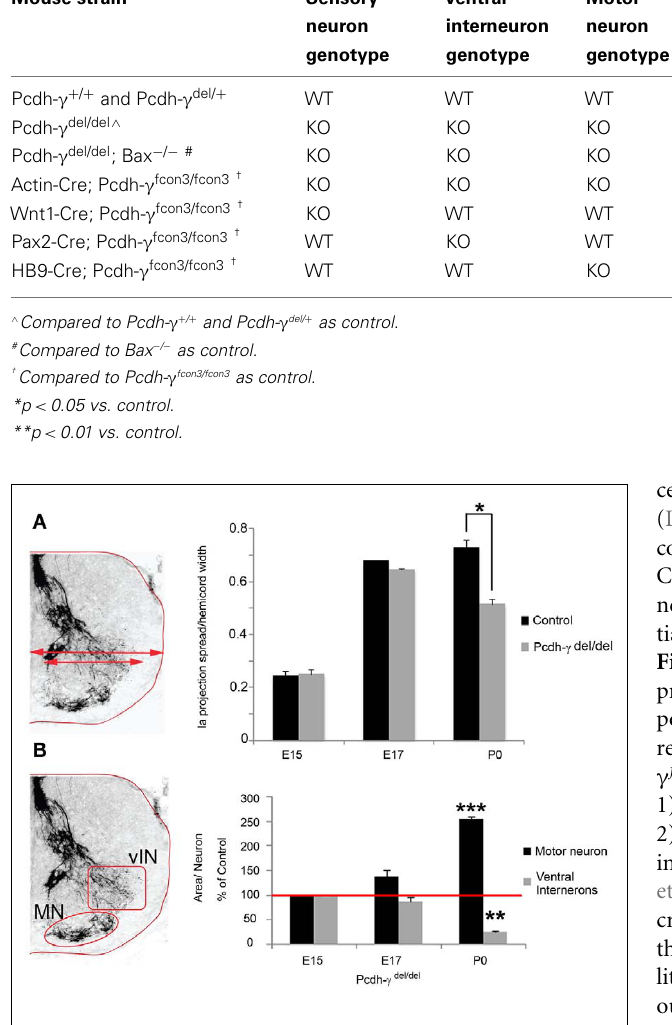
FIGURE 5 | Loss of Ia axon collateral projections to ventral interneurons in Pcdh- γ null mutants. (A) The extent of the spread in parvalbumin + Ia terminal arbors, normalized to hemi-cord width, was quantified as one measure of collateral formation (schematized at left). A significant reduction in the extent of Ia afferent terminal spread becomes apparent at P0. (B) Quantification of the area covered by parvalbumin + Ia terminals in the motor neuron (MN) and ventral interneuron (vIN) fields was normalized to neuron number (schematized at left). As mutant terminal density increases around MNs, it decreases around vINs, becoming significant at P0 (data are graphed as percent of E15 control levels). Red line indicates 100%. * p < 0.05; ** p < 0.01;*** p <